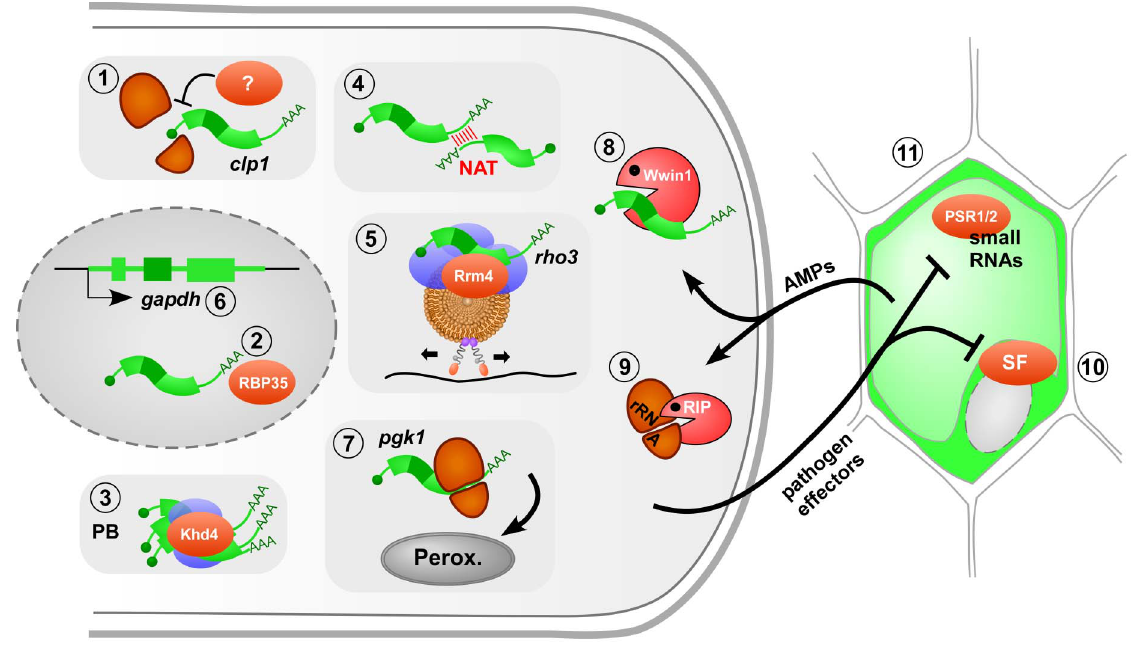
Figure 1. The role of fungal RNA biology during plant infection. Model of a filamentous pathogen (left) interacting with its plant host (right). RNA-dependent processes crucial for infection are numbered as follows: 1 translational regulation of clp1 mRNA (ribosomal subunits in orange, mRNA in green); 2 3 9 end processing by the RNA-binding protein RBP35 in the nucleus (gray oval); 3 modulation of mRNA stability in processing bodies (PB, blue: accessory factors); 4 natural antisense transcripts (NAT) regulate mRNA stability; 5 endosomal mRNA transport along microtubule (black line, brown: endosome with motor proteins attached); 6 alternative splicing of gapdh mRNA to generate an enzyme with a peroxisomal targeting sequence; 7 translational read-through adding a peroxisomal targeting sequence; 8 antimicrobial peptide (AMP) Wheatwin1(Wwin1) with RNase activity; 9 ribosome-inactivating protein (RIP) alters rRNA; 10 pathogen effectors target host splice factors (SF) as shown for the bacterial effector HopU1 inactivating AtGRP7; 11 pathogen effectors interfere with the generation of small RNAs in the host as shown for oomycetes effectors. Further details are given in the text.